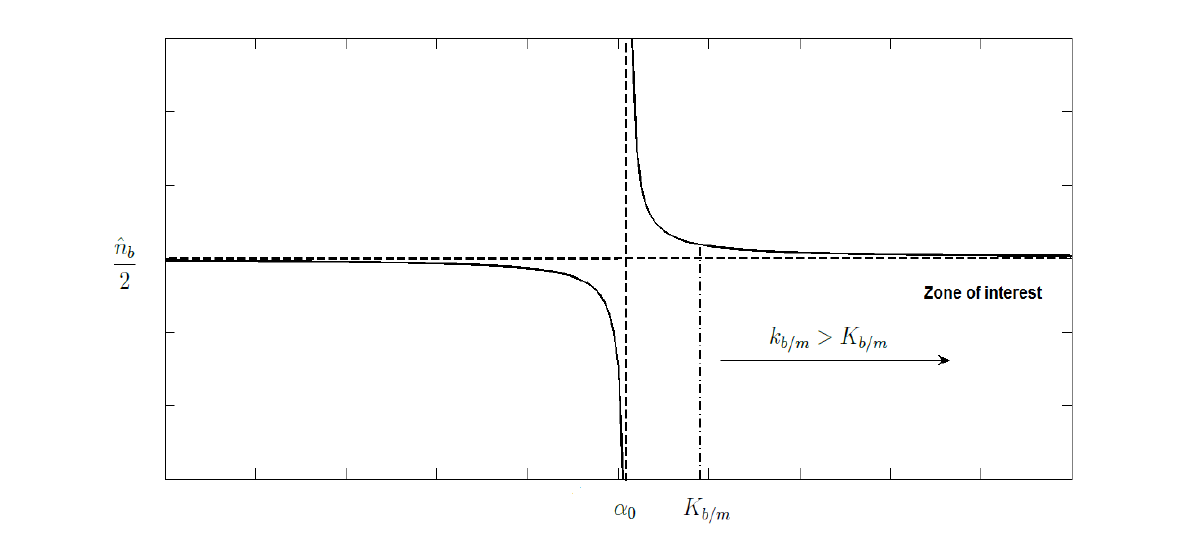
Figure 7. Best response probability p ∗